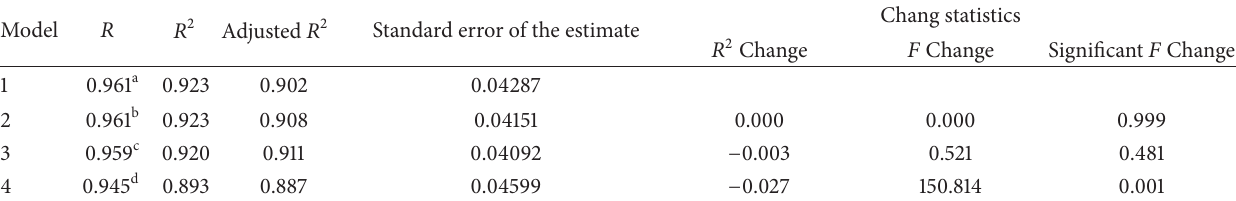
Table 7: Statistics summary of each regression